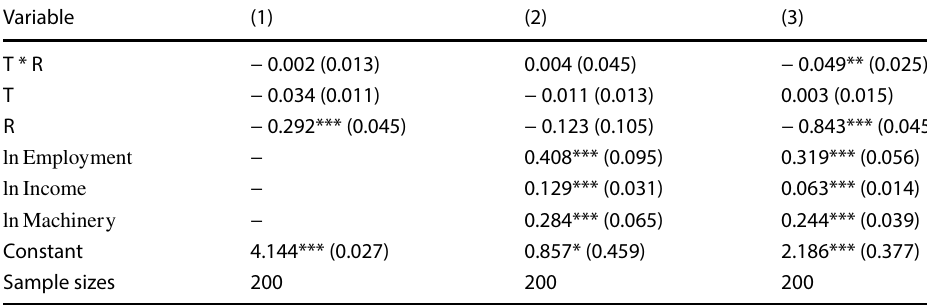
Table 13 Placebo test